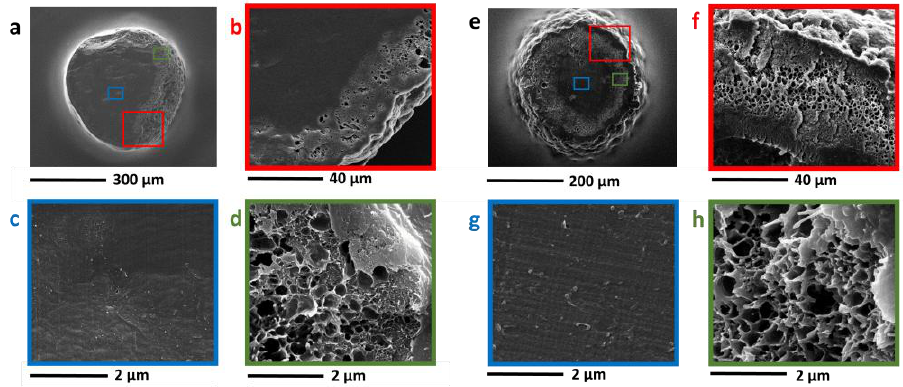
Figure 8. TEM micrographs of sections of the nanocomposite ( a – d ) DVB/VBC and ( e – h ) DVB/ ST/VBC beads containing 3 phr carbon nanotubes (CNT). Reproduced from Ref. [114] with permission from the Royal Society of Chemistry (London, UK).